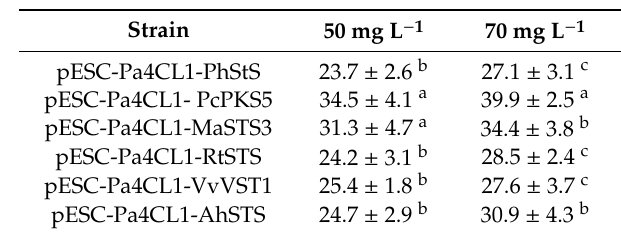
Table 2. Production of resveratrol at two concentrations of p -coumaric acid (50 and 70 mg L − 1 ) after 60 h batch